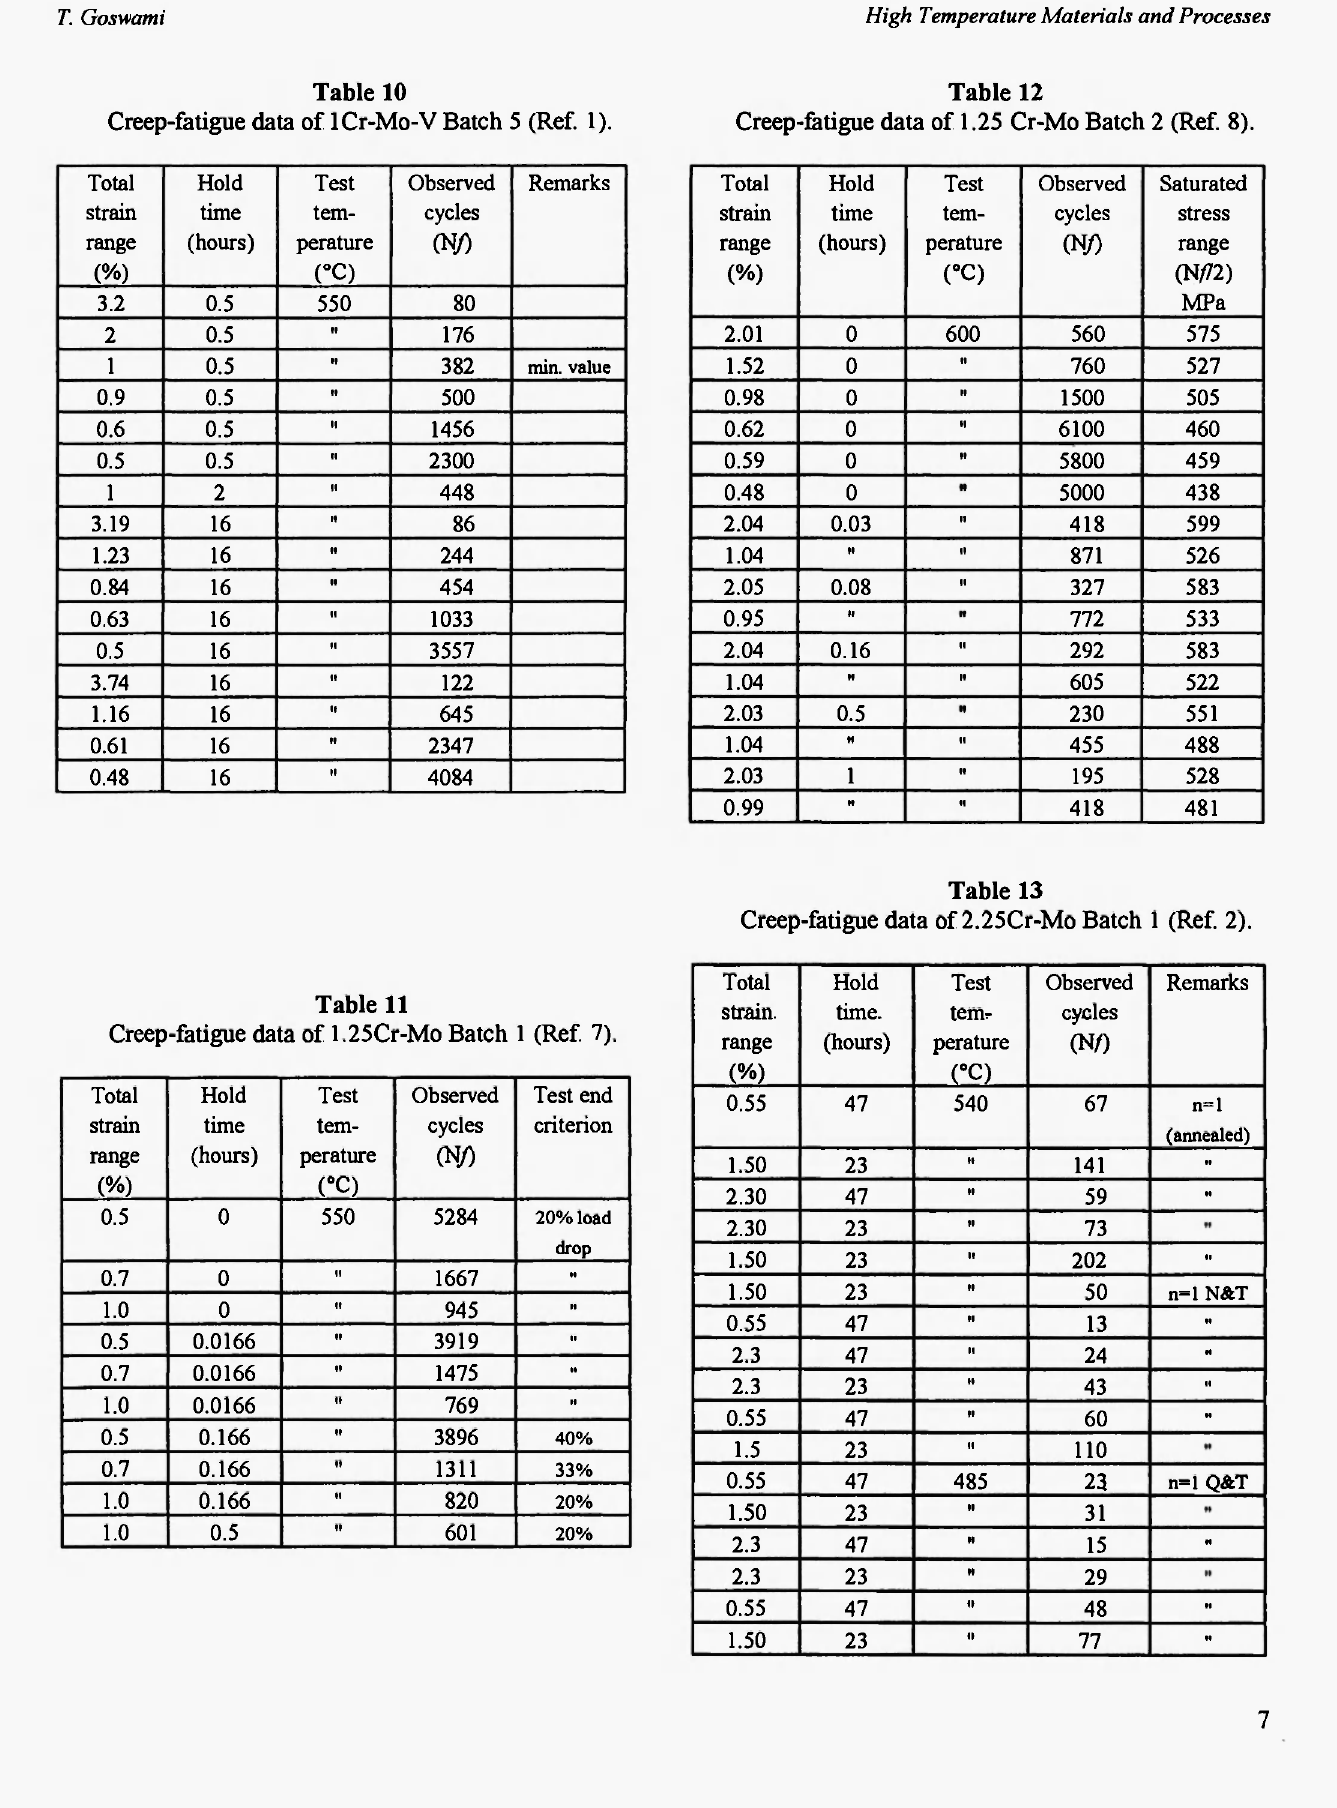
Creep-fatigue data of lCr-Mo-V Batch 5 (Ref. 1).